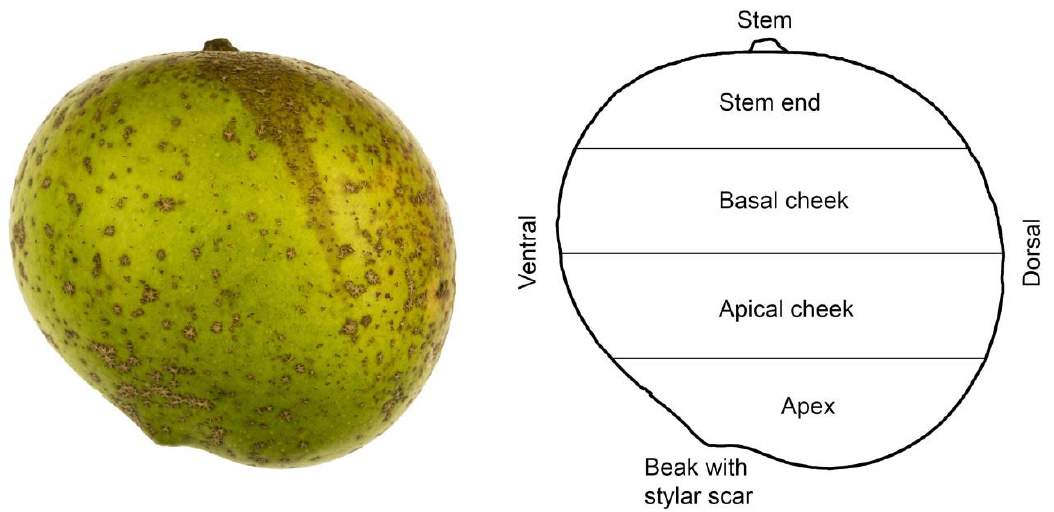
Figure 7. Photograph of ‘Apple’ mango and sketch illustrating the nomenclature used to describe regions of the fruit surface [41] .